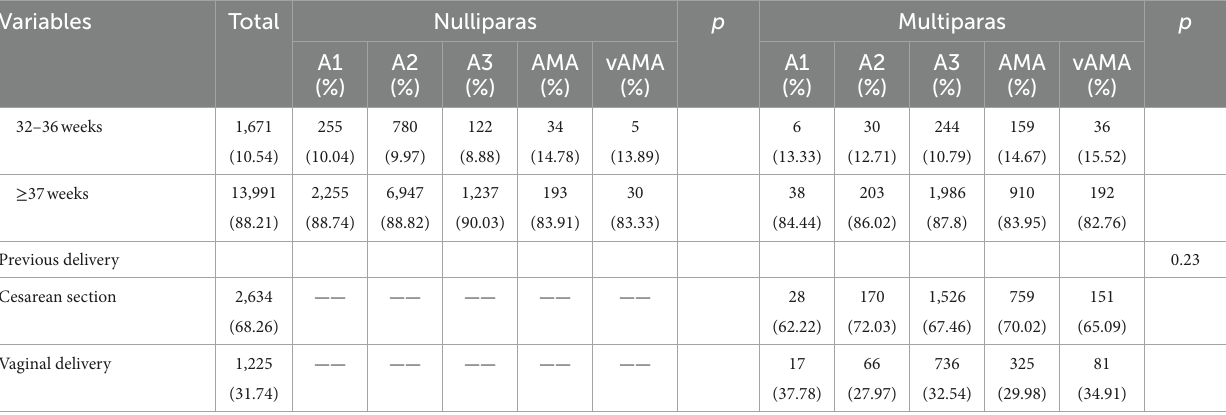
TABLE 2 Incidences of adverse pregnancy outcomes and neonatal outcomes for the single age